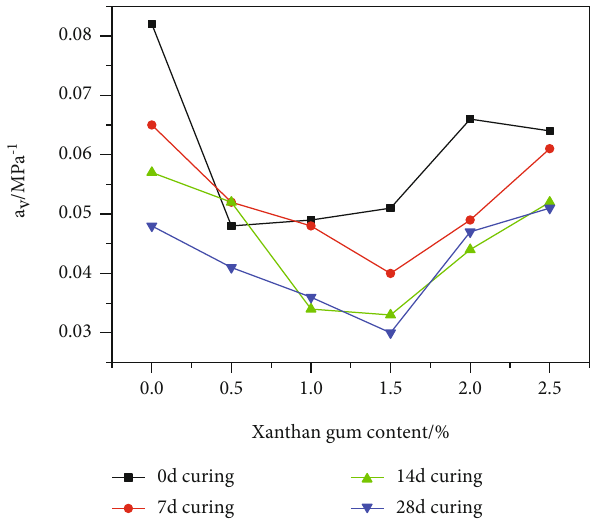
Figure 8: Relationship of curing ages and compression coe ffi cient.